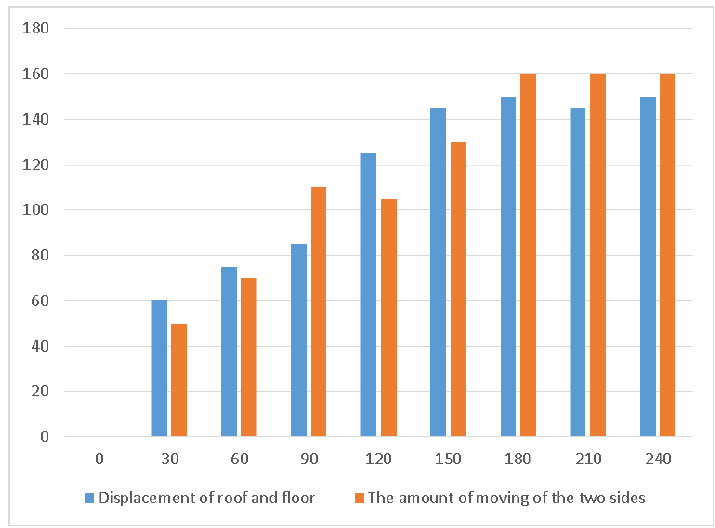
Fig. 4 Field measurement and